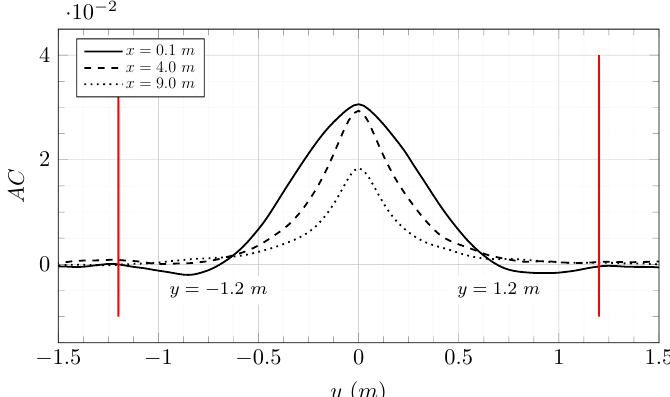
Figure 14. Results of the autocorrelation function applied to the velocity field computed from a = 0.01638 m 2 .s − 2 and ∆ x = 0.035 m. x is LBM-LES simulation using DFSEM with L = 1.2 m, u (cid:48) 2 i the distance from the inlet of the LBM domain. y is the distance from the centre of the domain in the span-wise direction. Turbulence rates from a LBM-LES simulation using DFSEM with L = 1.2 m, = 0.01638 m 2 .s − 2 and ∆ x = 0.025 m. x is the distance from the inlet of the LBM domain. Turbu- u (cid:48) 2 i